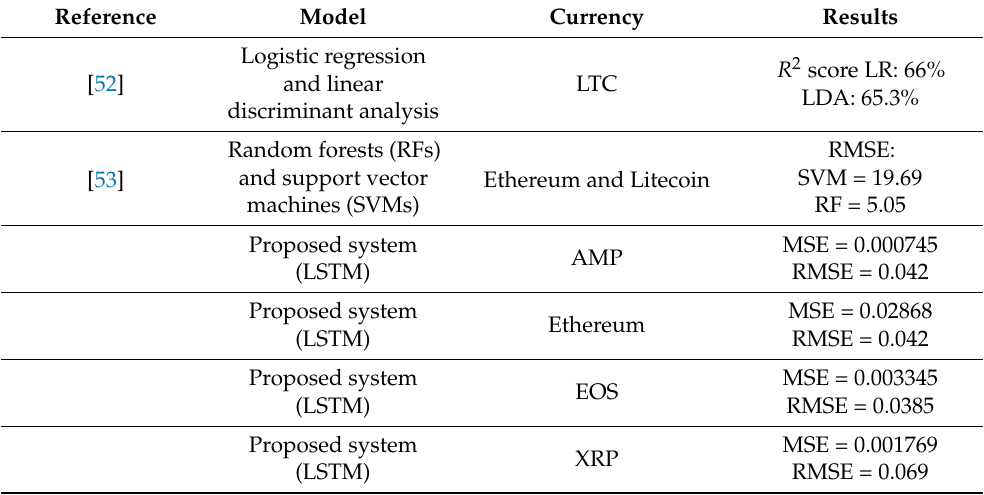
Table 11. Comparison results between the proposed system and the existing